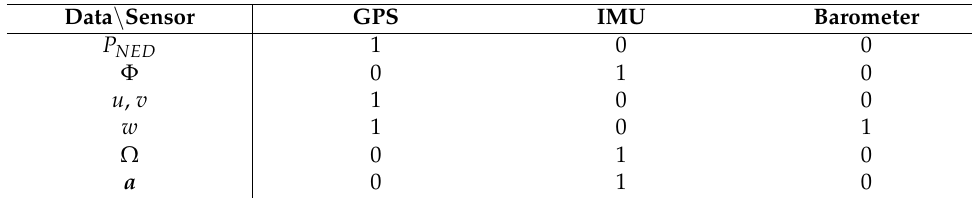
Table 5. Configuration for measurement update